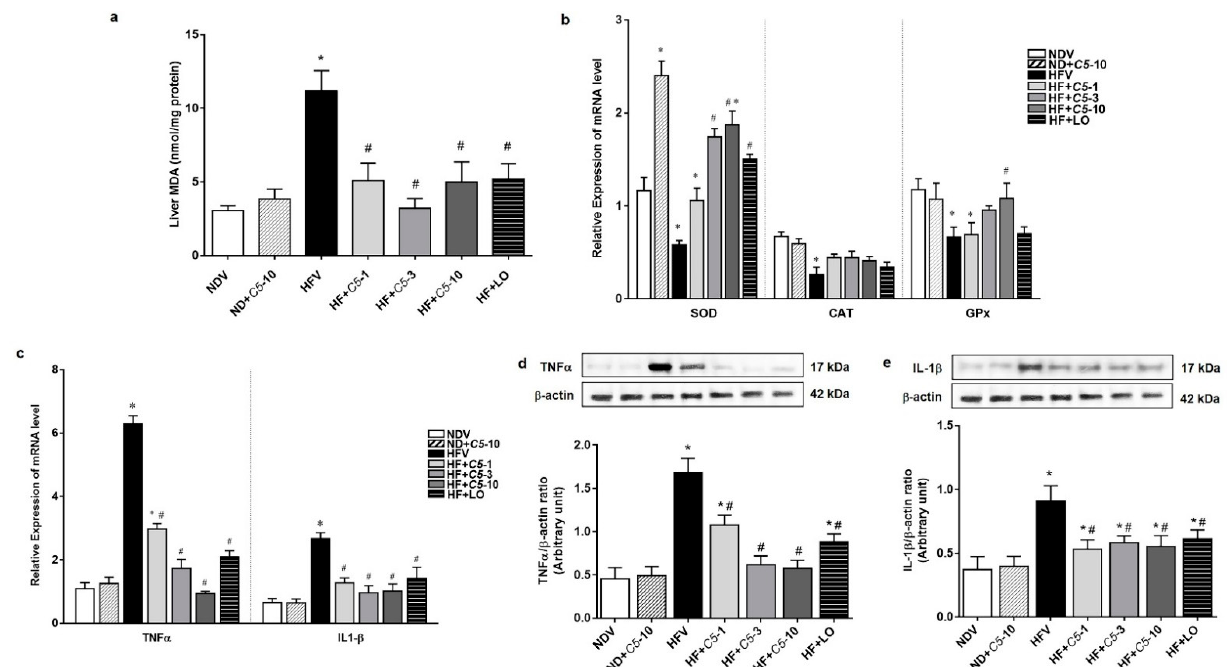
Figure 6. Antioxidant and Anti-inflammatory effects of α , β -dehydromonacolin S ( C5 ). ( a ) The malondialdehyde (MDA) level ( n = 6), ( b ) mRNA expression of Cu-ZnSOD, CAT, and GPx, ( c ) TNF- α and IL1- β mRNA expression, ( d ) expression of TNF- α , and ( e ) IL1- β protein extracted from rat liver tissues. A representative blot of TNF- α , and IL1- β protein expression is shown on the top panel and quantification of relative protein expression in each experimental group presented on the bottom. Anti- β -actin antibody was used as loading control. Values are shown as mean ± S.E.M ( n = 5), * p < 0.05 represents the significant difference compared with the NDV group and # p < 0.05 represents the significant difference compared with the HFV group.